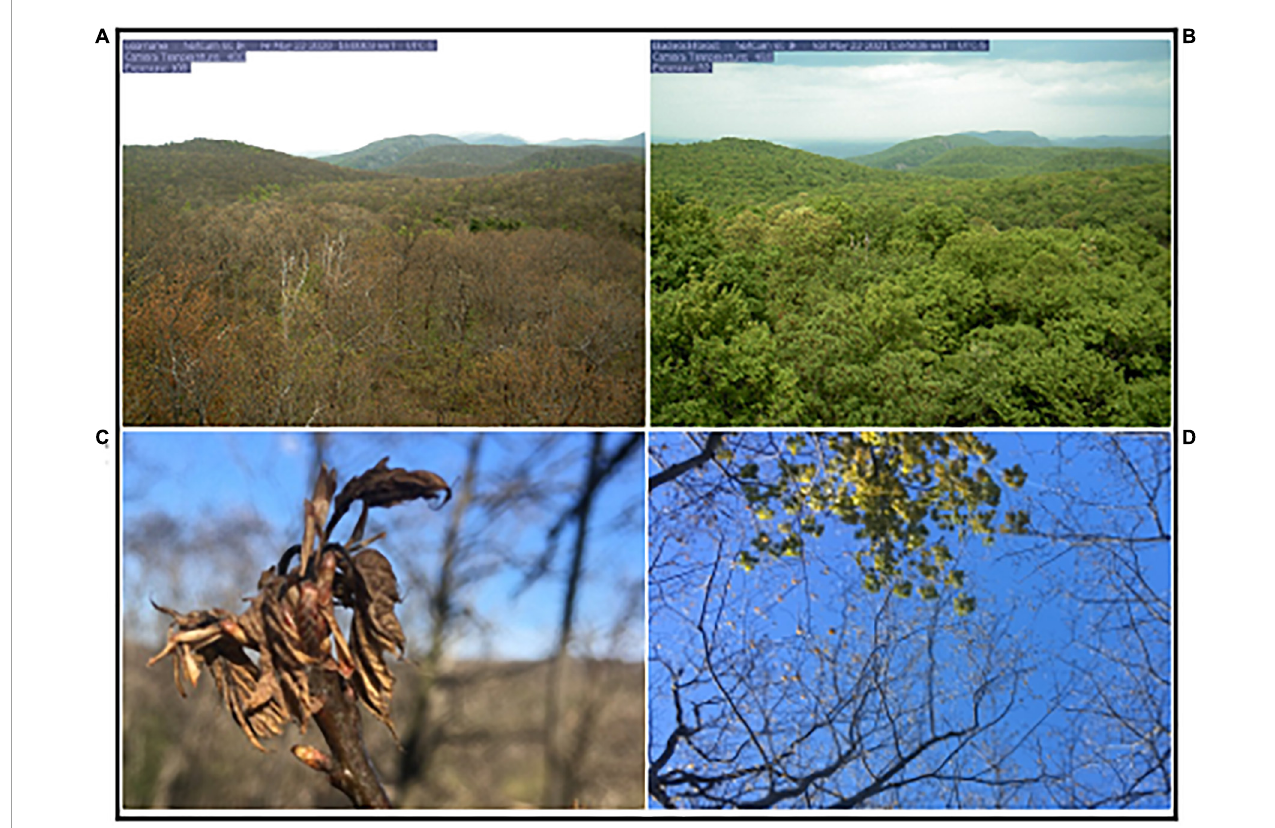
FIGURE3 Images of impacts of spring freeze defoliation at Black Rock Forest including phenocam images from May 22, 2020 (A) and May 22, 2021 (B) , frost-killed oak leaves (C) , and canopy with red maple tree fully leafed-out and defoliated oaks in the background (D) . Note, text in images includes image metadata associated with all phenocam images and is not relevant to the current